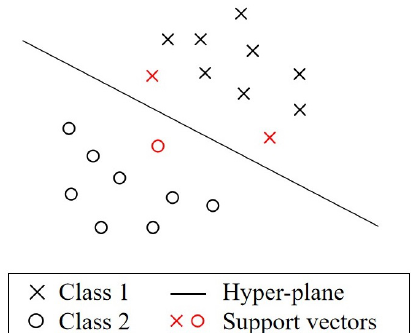
Figure 25. Support vector machine, where Class 1 and Class 2 represent the samples of two different type of targets.